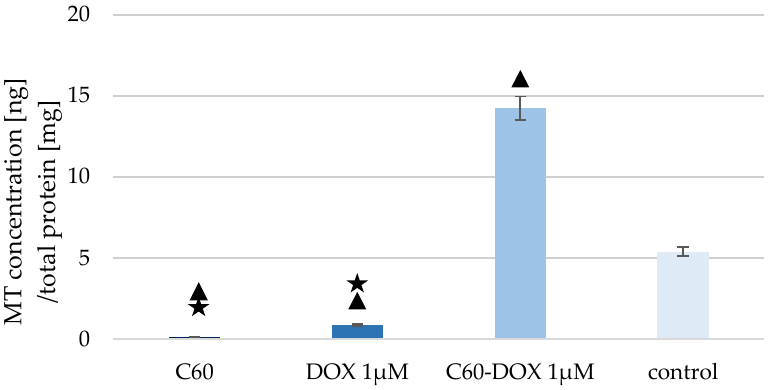
Figure 3. MT concentration in MCF-10A cells treated with C 60 , DOX and C 60 – DOX complex. The triangle marks a statistically significant difference compared with the control ( p < 0.05). The asterisk marks statistically significant difference compared with the C 60 – DOX ( p < 0.05).